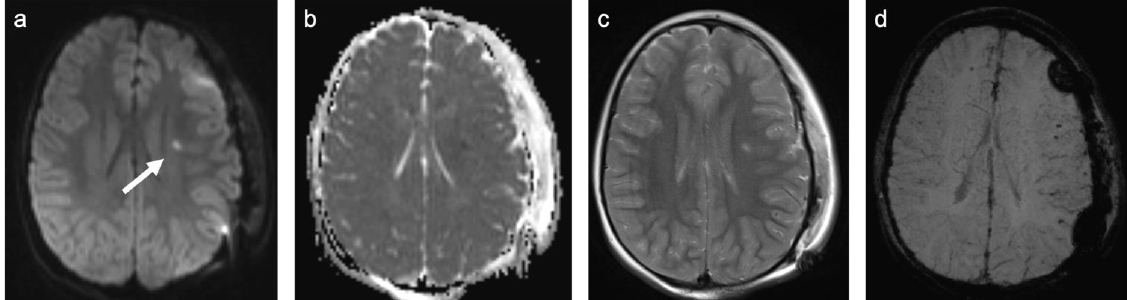
Figure 5. Representative case “Traumatic white matter injuries”: diffuse axonal injury. DWI/ADC ( a , b ), T2W ( c ), and Susceptibility weighted imaging (SWI; ( d )) sequences. Fourteen-year-old girl admitted after a traumatic car accident during which she was ejected from her seat. MRI shows a diffusion restricted, diffuse axonal injury lesion in the lobar white matter ( a – c , white arrow). SWI demonstrates small regions of susceptibility artefacts at the grey–white matter junction corresponding to cerebral microbleeds ( d ). Additional findings are a subgaleal fluid collection (left side) following craniotomy for treatment of cranial impression fracture.